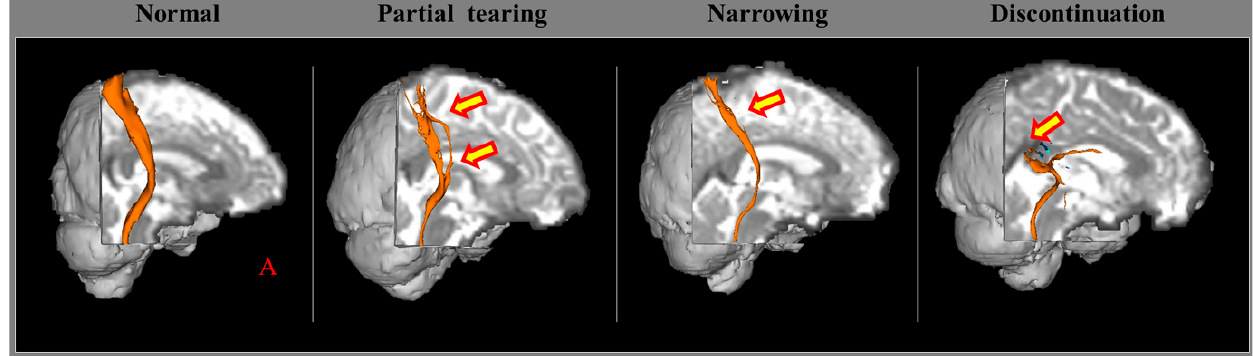
Figure 3. Configurational analysis of the spinothalamic tract in patients with mild traumatic brain injury. The right spinothalamic tract shows partial tearing (A), narrowing or discontinuation (arrow) (reprinted with permission from [13]).